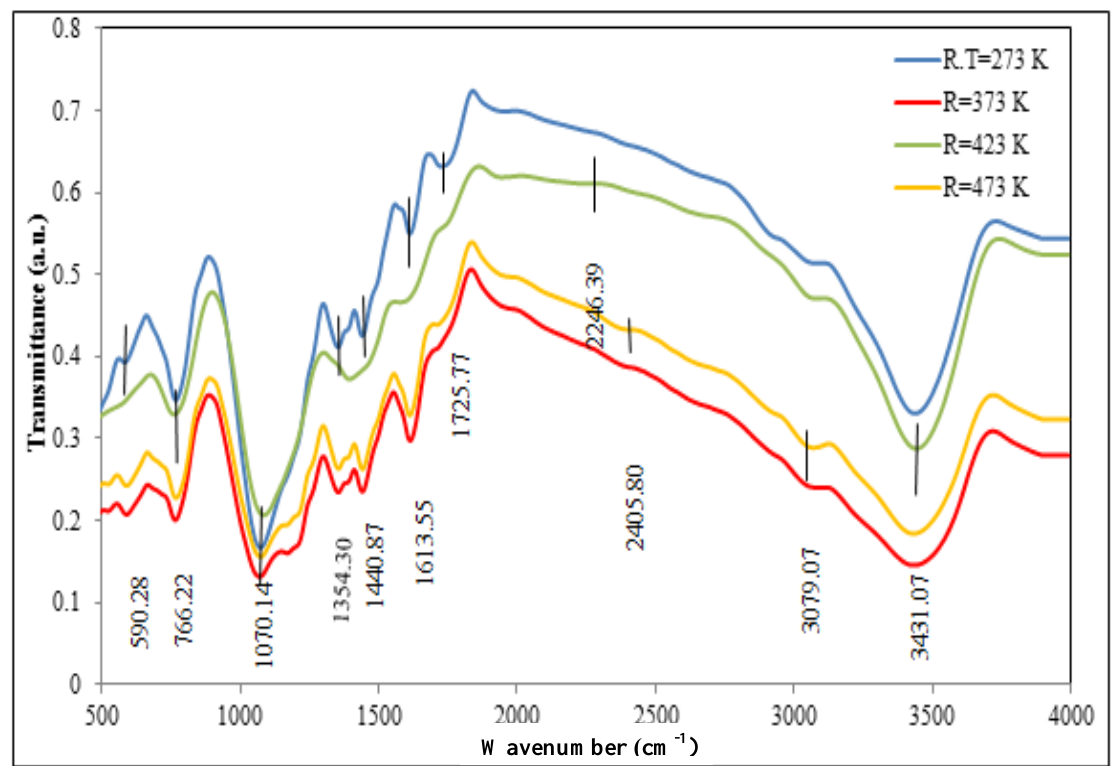
Fig.7: FTIR spectra for as-deposited and annealed blend NiPcTs/Alq